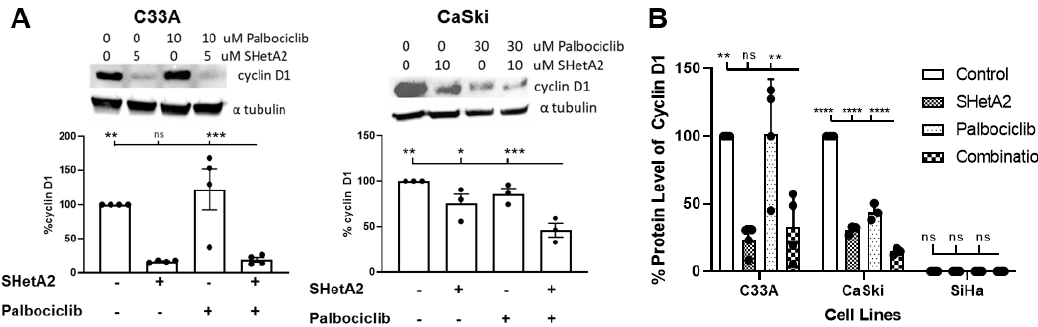
Figure 2. Cyclin D1 levels in cultures treated with the indicated concentrations of SHetA2, palbociclib or the combination of these two drug for 24 h. ( A ) Representative western blots of C33A and CaSki cervical cancer cell lines are shown on top and graphs of cyclin D1 band intensities in replicate experiments are shown below. ( B ) Average of three independent cyclin D1 ELISA measurements in the indicated cell lines treated with the indicated drugs. ANOVA comparison of combination treatment with other treatment groups: ns = not significant, p value > 0.05 and < 0.01, * = p < 0.05, ** = p < 0.01, *** p < 0.001, **** p < 0.0001. The whole Western Blot see Figure S3.